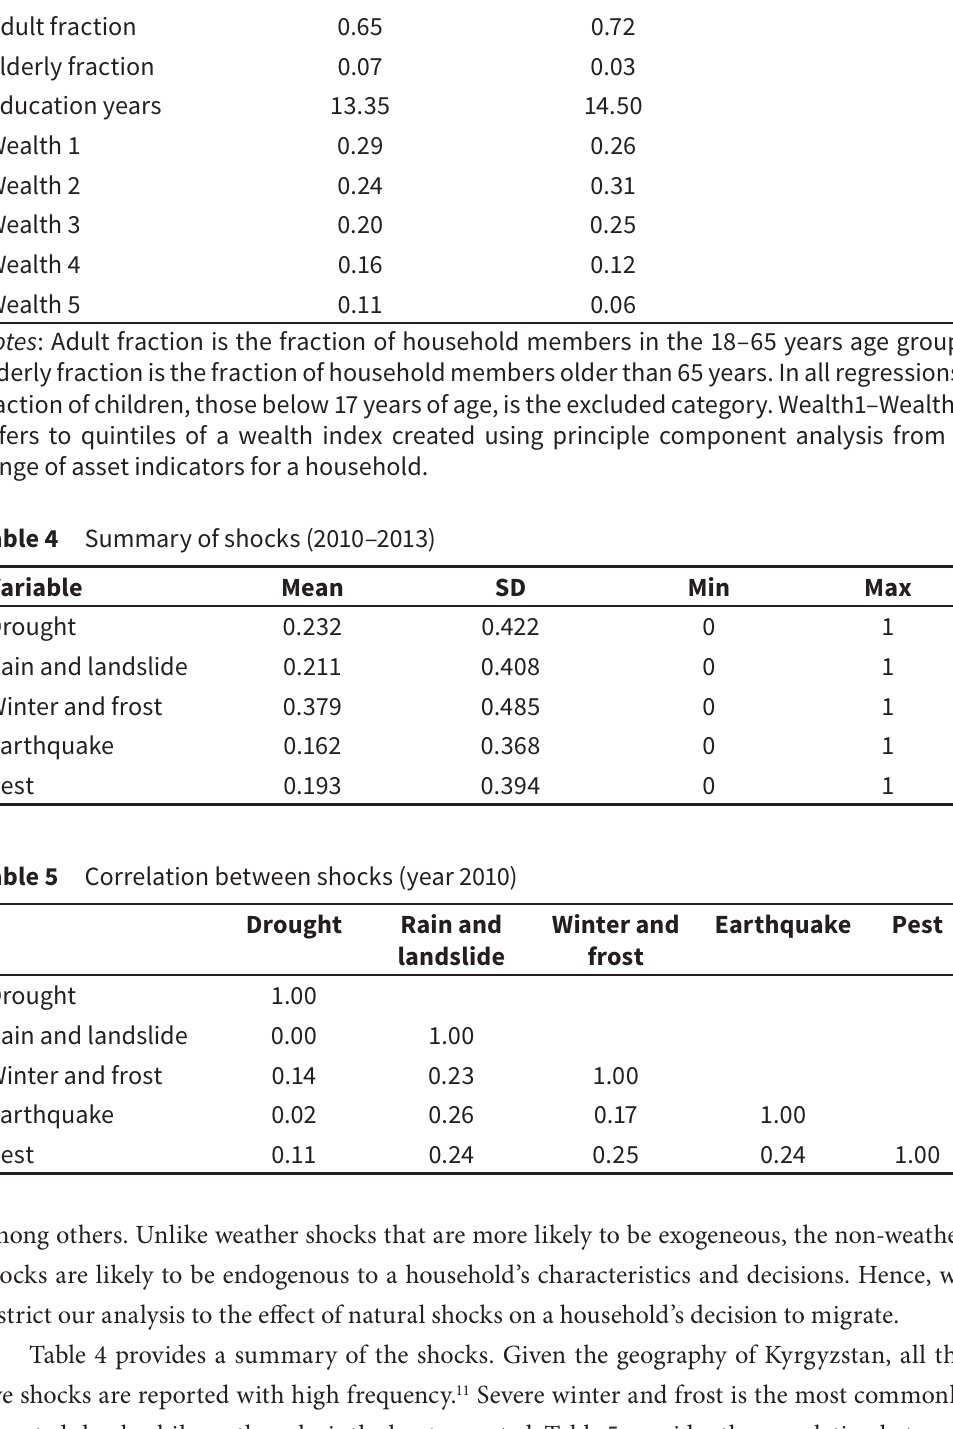
Summary statistics (year 2010) Variable Non-migrant